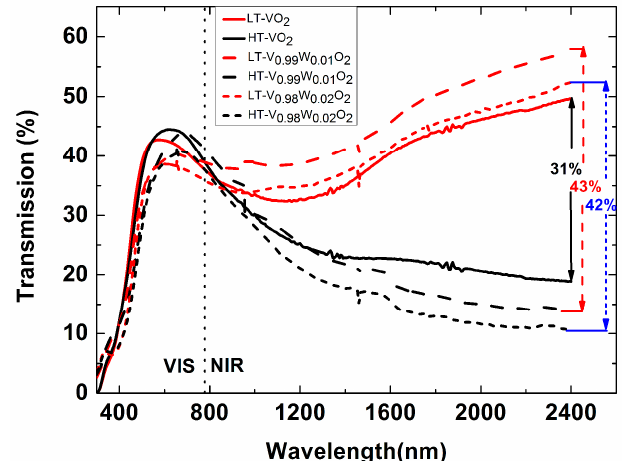
Figure 4. Visible and near-infrared transmission spectra of pure VO 2 , V 0.99 W 0.01 O 2 and V 0.98 W 0.02 O 2 films before (10 °C) and after (100 °C) PTT, respectively. The films were annealed at 530 °C for 30 min with oxygen pressure of 18 Pa.